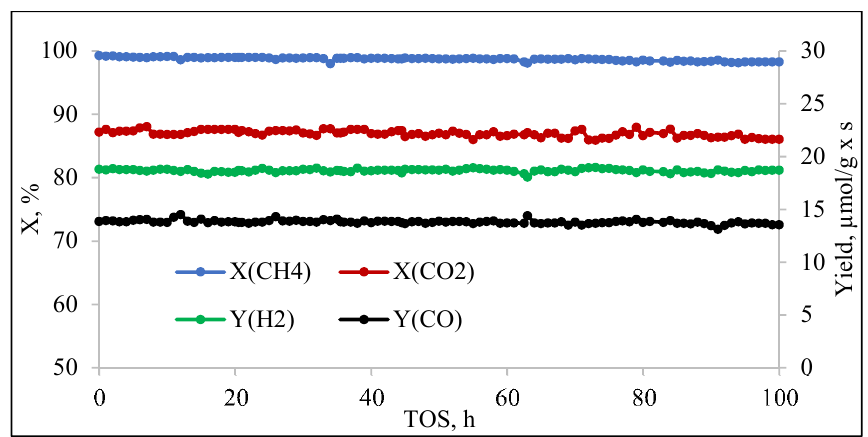
Figure 13. Dependence of CO 2 -CH 4 conversion and H 2 and CO yield on process duration in BRM over the 5%Co-Rh(98:2)/Al 2 O 3 catalyst at СН 4 :СО 2 :H 2 O = 1:1:0.5, t = 670°C, Р = 1 atm, GHSV = 1250 h −1 .